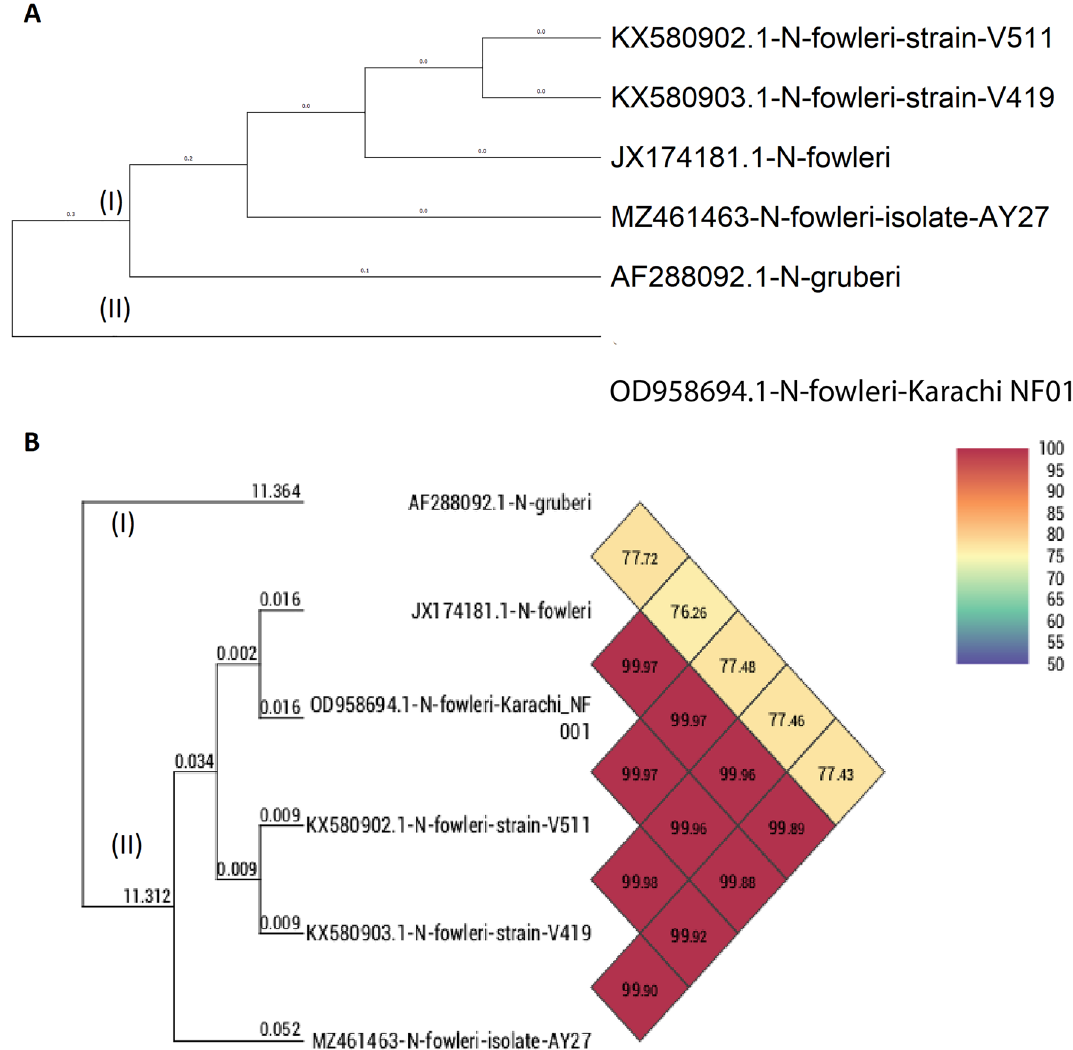
Figure 3. Whole mtDNA sequences were aligned and the phylogenetic tree was generated using the neighbour- joining method with 1000 bootstrap replicates ( A ) and heatmap showing the OrthoANI (Orthologous Average Nucleotide Identity) between N. fowleri isolate AY27 (MZ461463)) and other N. fowleri isolate calculated with OAT software, and N. gruberi species (AF288092.1) used as the outgroup ( B